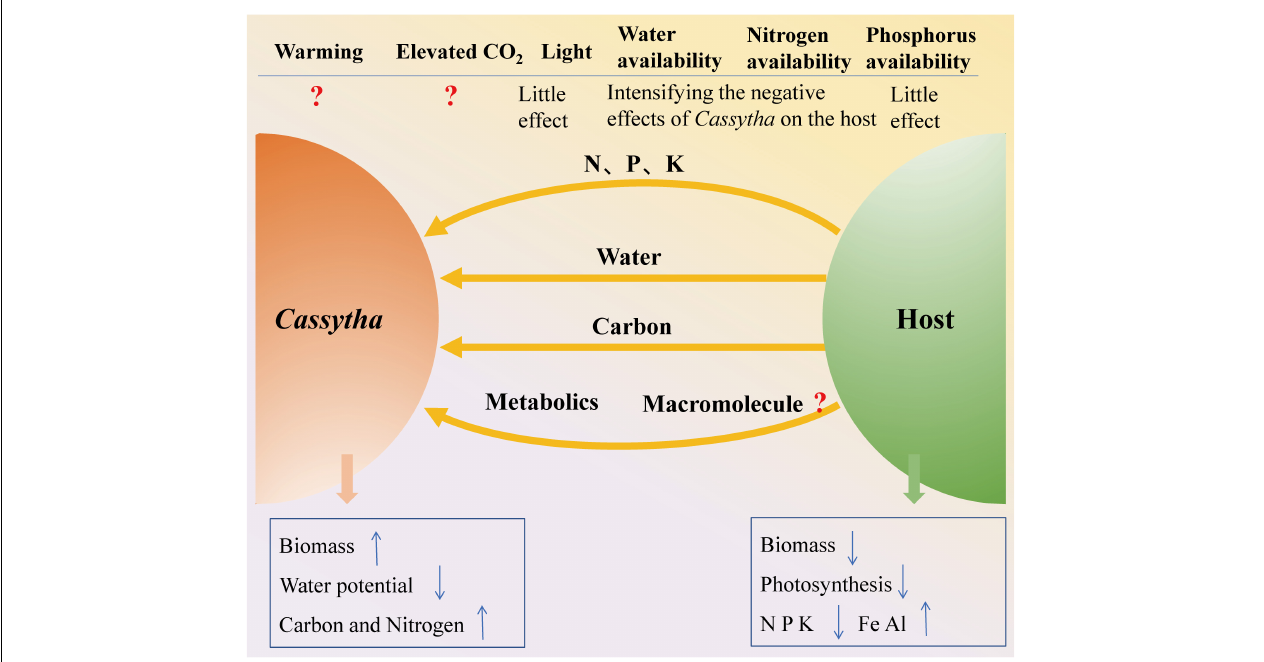
FIGURE 3 | Frame diagram of Cassytha –host interactions and the impacts of environmental